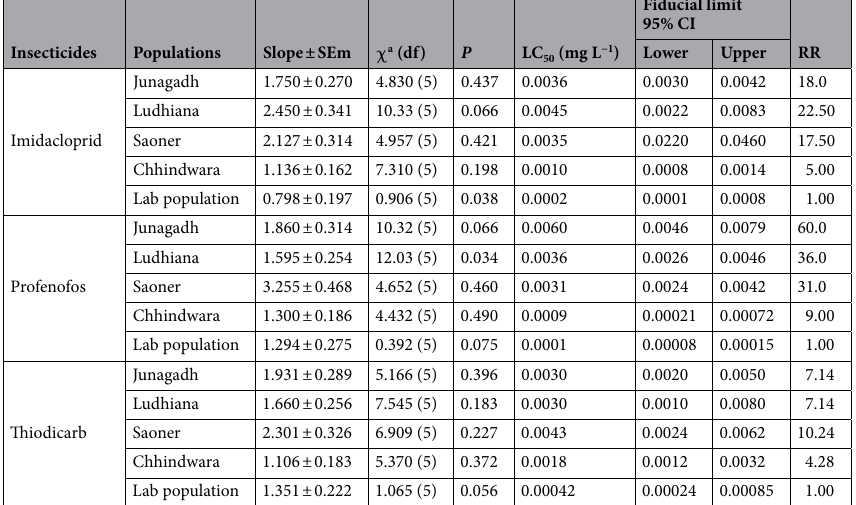
Table 3. Residual toxicity of imidacloprid, profenofos and thiodicarb against field populations Aenasius arizonensis . SE, Standard Error; χ 2 ,chi-square test of goodness of fit of concentration-mortality response; df, Degrees of freedom; LC, Lethal Concentration; FL, Fiducial Limits; Relative Resistance (RR) = LC 50 of field population/LC 50 of laboratory reared Susceptible check.